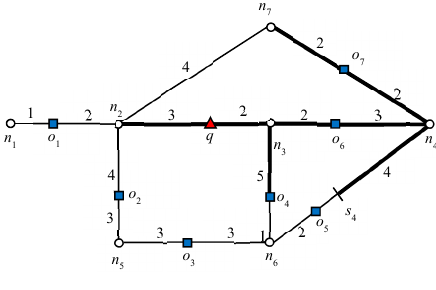
Figure 4. Influence region of o 6 .